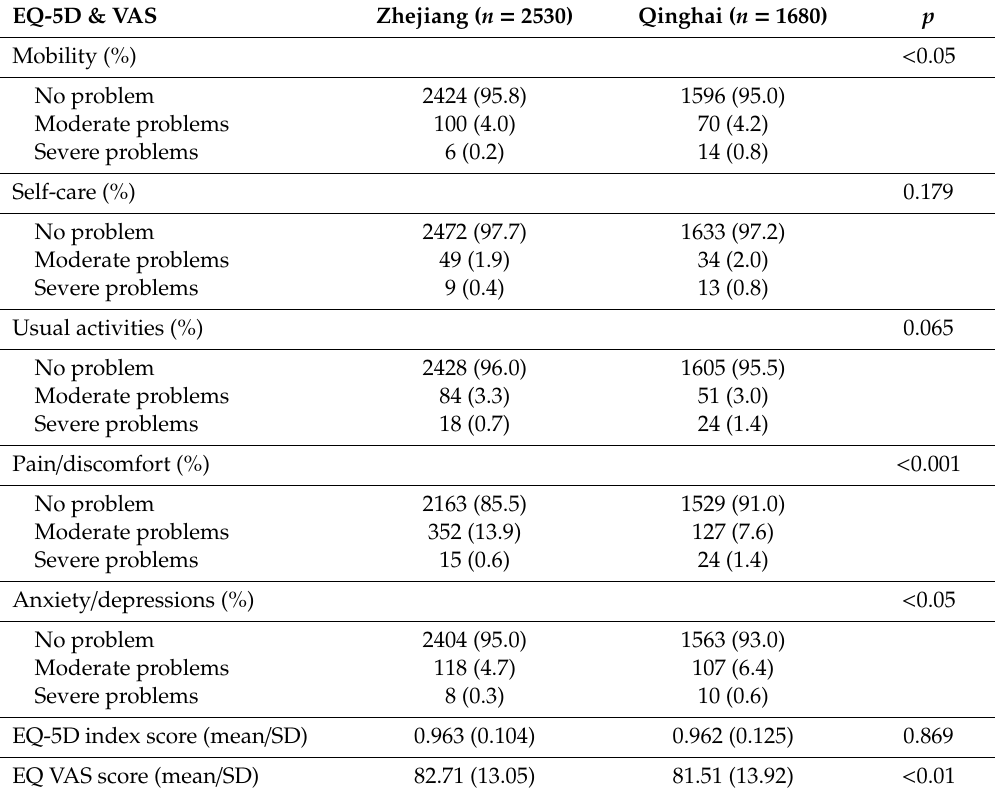
Table 3. Five dimensions of EQ-5D and visual analogue scale (VAS)